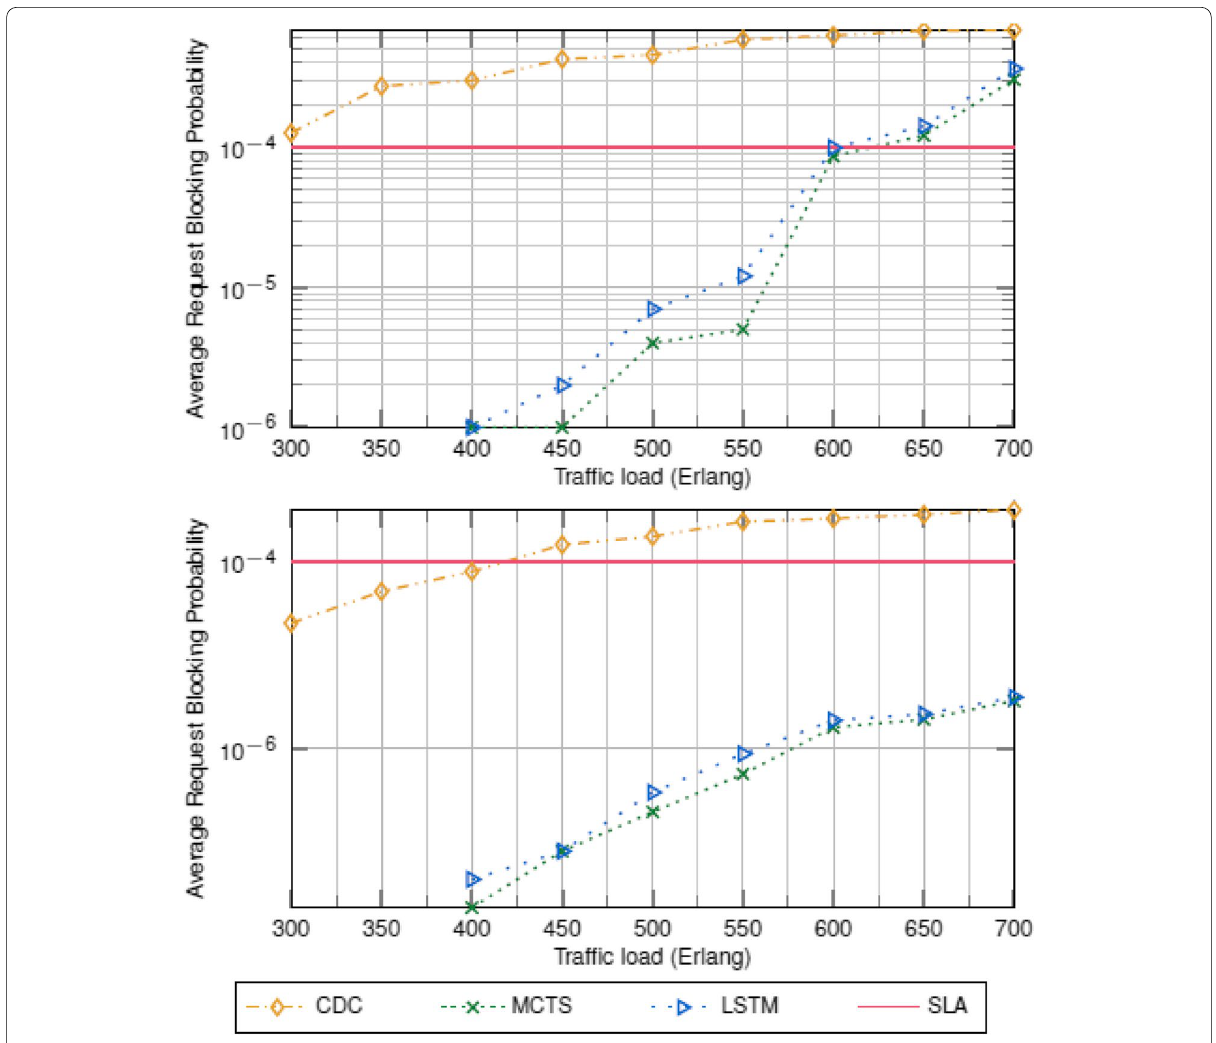
Fig. 5 Scenario #1: The Euro28 (on top) and the US26 (bottom)